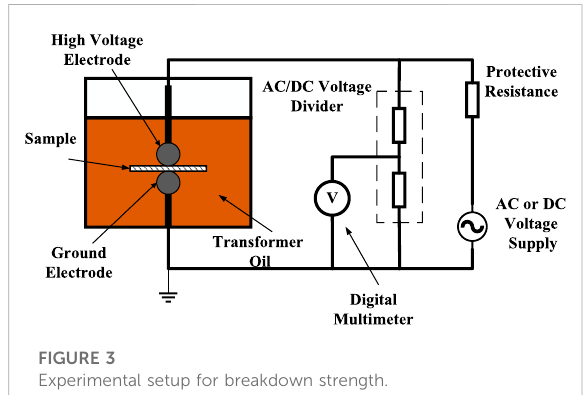
FIGURE 3 Experimental setup for breakdown strength.